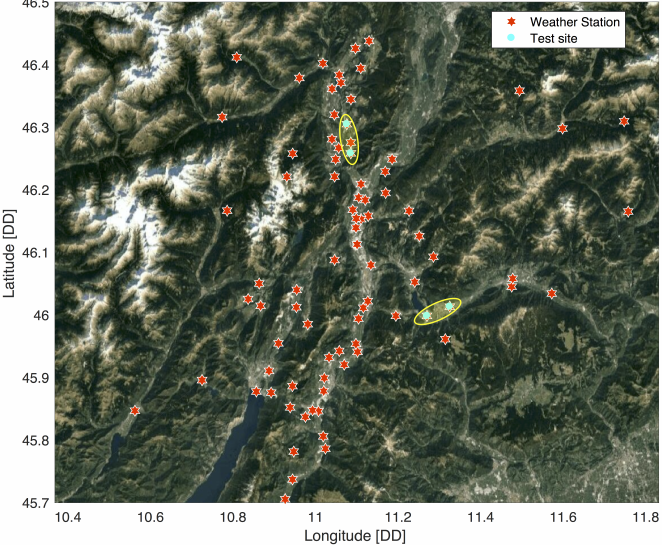
Figure 4. Edmund Mach Foundation weather station positions in the Trentino region. The light blue circles represent the zones used in this paper as